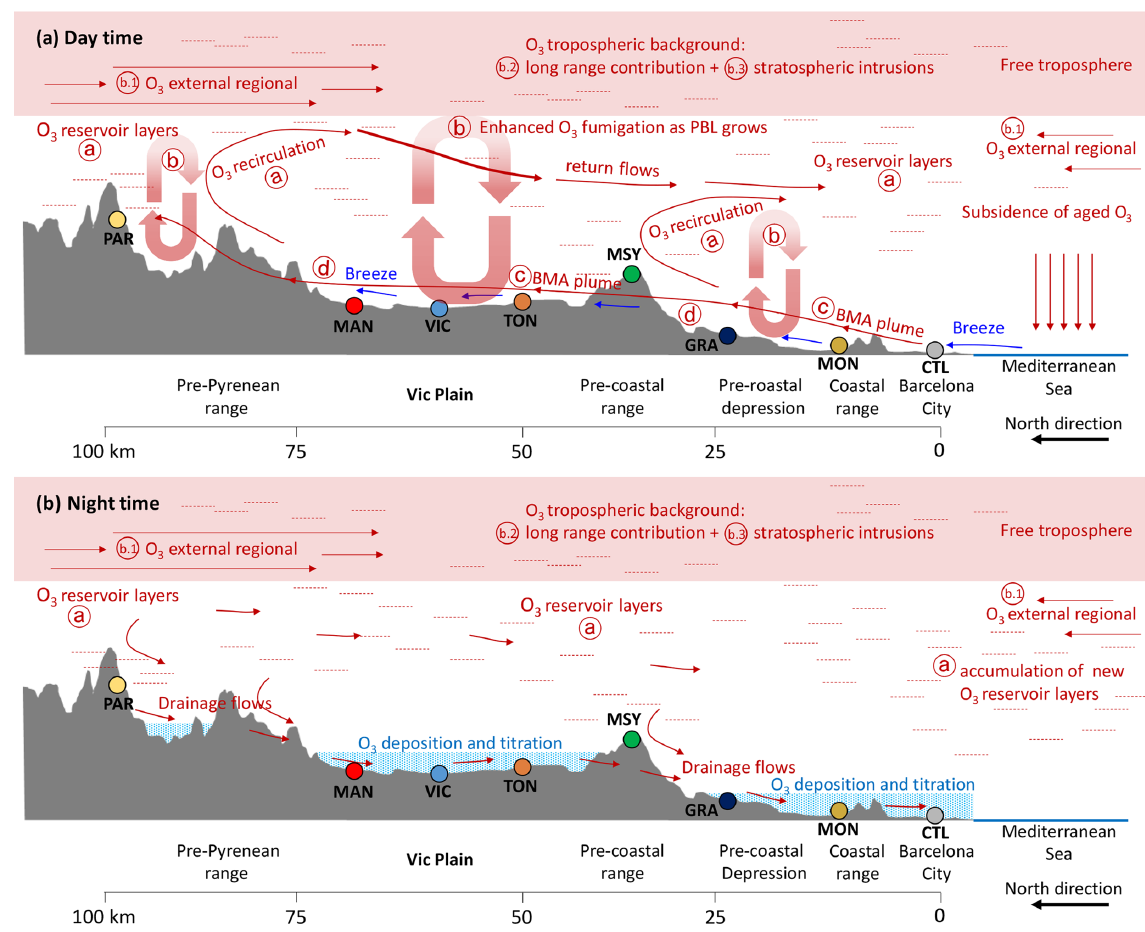
Figure 12. Idealized two-dimensional section of O 3 circulations in the coastal region of Barcelona to the Pre-Pyrenees on a typical summer day (a) and night (b) . The gray shaded shape represents a topographic profile in the south-to-north direction from the Mediterranean Sea to the southern slopes of the Pre-Pyrenean ranges (i.e., along the S–N axis). The colored dots and abbreviations depict the air quality monitoring stations located along the S–N axis: Ciutadella (CTL), Montcada (MON), Granollers (GRA), Montseny (MSY), Tona (TON), Vic (VIC), Manlleu (MAN) and Pardines (PAR). Modified and adapted to the S–N axis from Millán et al. (1997, 2000) and Querol et al. (2017,